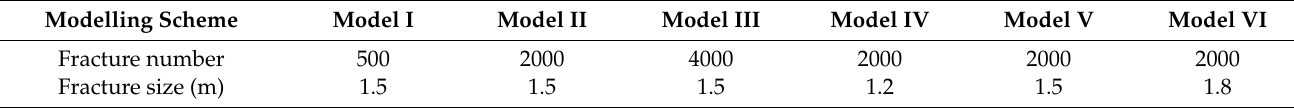
Table 4. The designed modeling